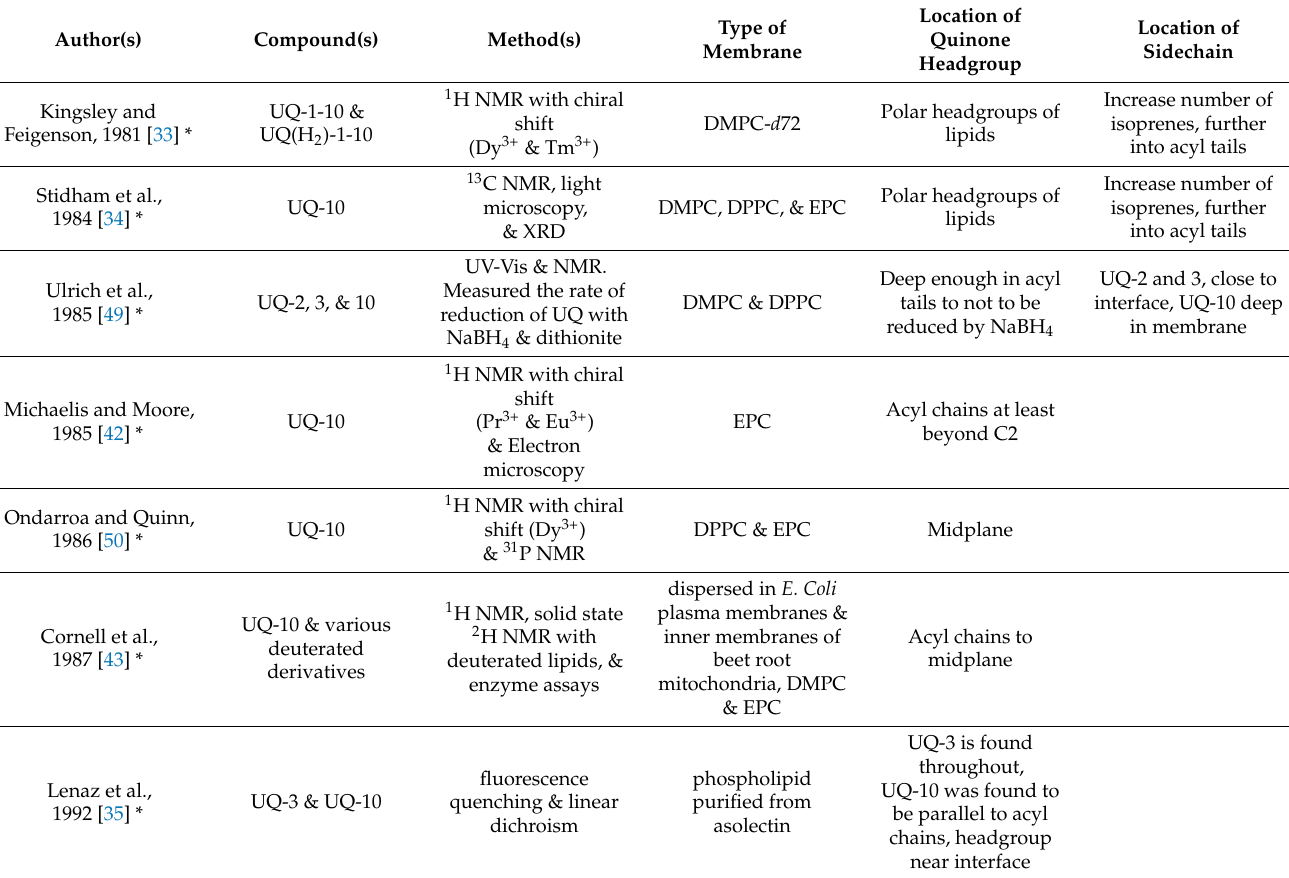
Table 3. Summary of the studies reported relating to the location of the ubiquinone